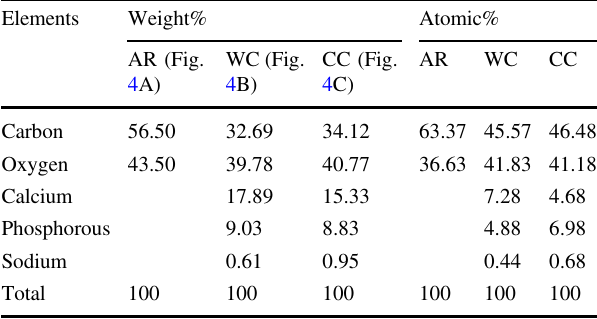
Table 2 EDX analyzed elements of AR, WC, and CC Elements